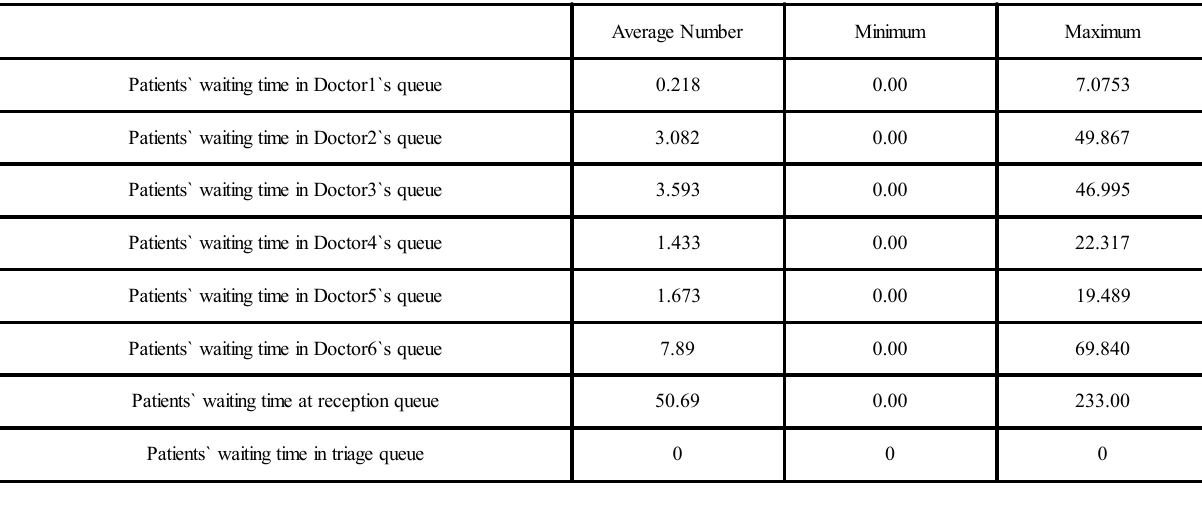
TABLE 5. PATIENTS WAITING TIME IN DIFFERENT WAITING